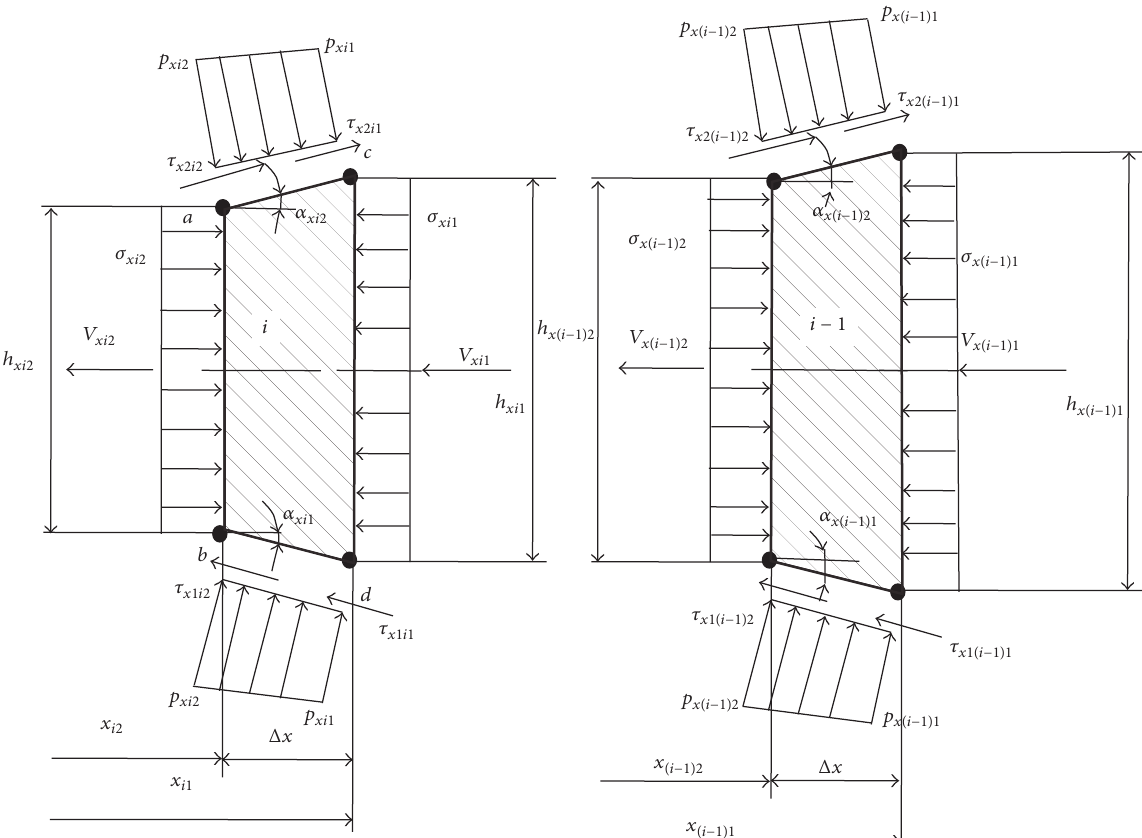
Figure 2: Design diagrams of elementary volumes of mathematical modeling of stress-strain state of the compact material.